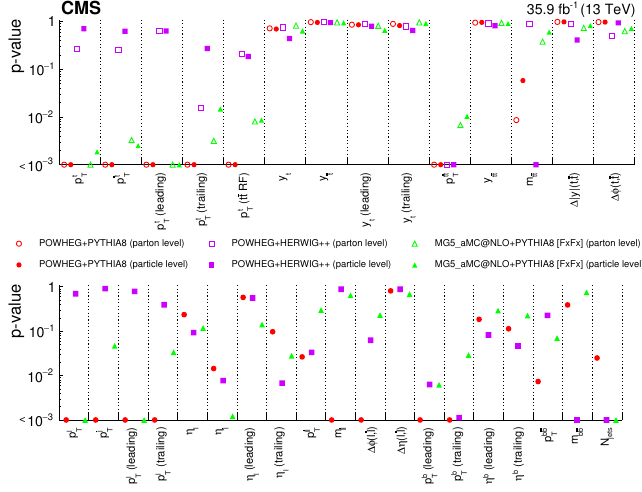
Figure 52 . The p -values quantifying the agreement between the data and MC predictions from for all normalised measurements are shown. Points situated on the horizontal axis indicate p -values less than 0.001. The upper panel includes distributions measured at parton and particle levels while the bottom panel includes those measured at particle level only.